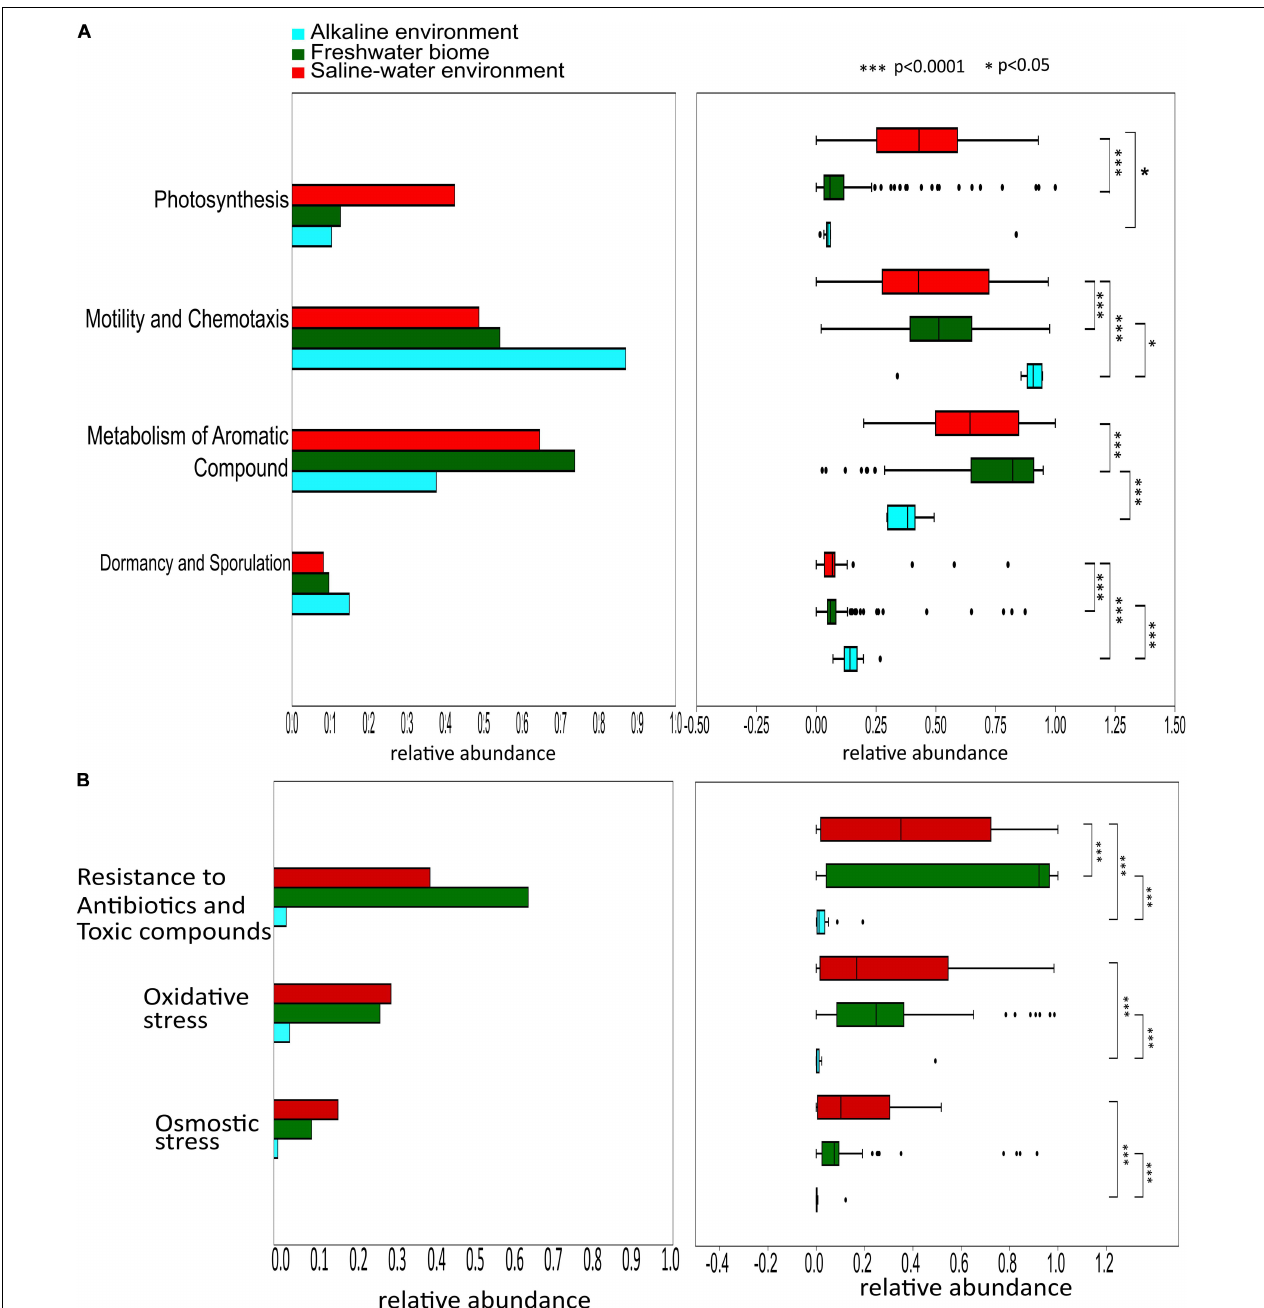
FIGURE 6 | Differential abundance of the protein features associated Dormancy and Sporulation, Motility and Chemotaxis, Metabolism of aromatic compounds, and Photosynthesis ( p < 0.05) among saline, freshwater, and alkaline metagenomes (A) . Comparative analysis shows metabolic features associated with the protection from osmotic stress, oxidative stress, antibiotic, and metal/metalloid toxicity among saline, freshwater, and alkaline ecosystems indicating the significantly diverse abundance ( p < 0.05) of these metabolic features in these ecosystems (B)